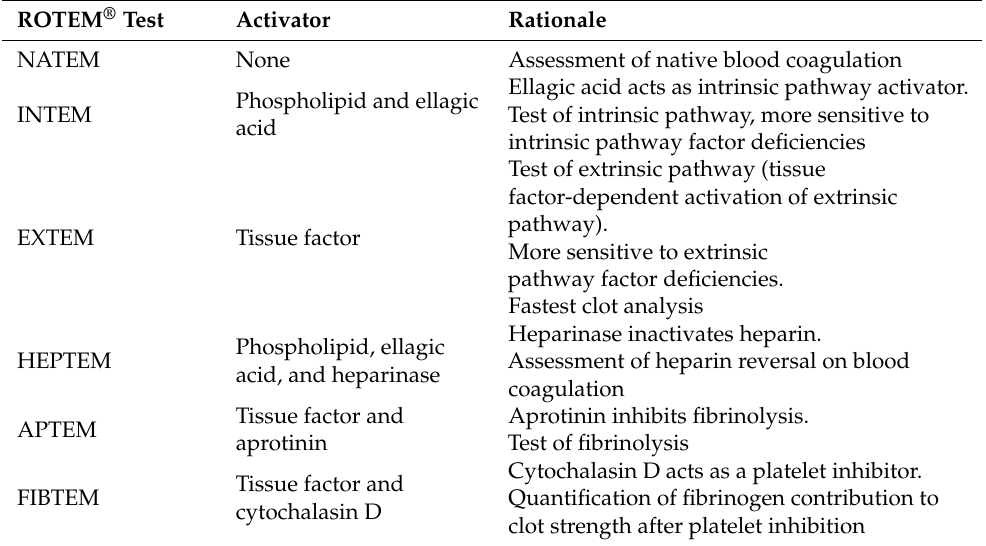
Table 3. Commercially available ROTEM ®